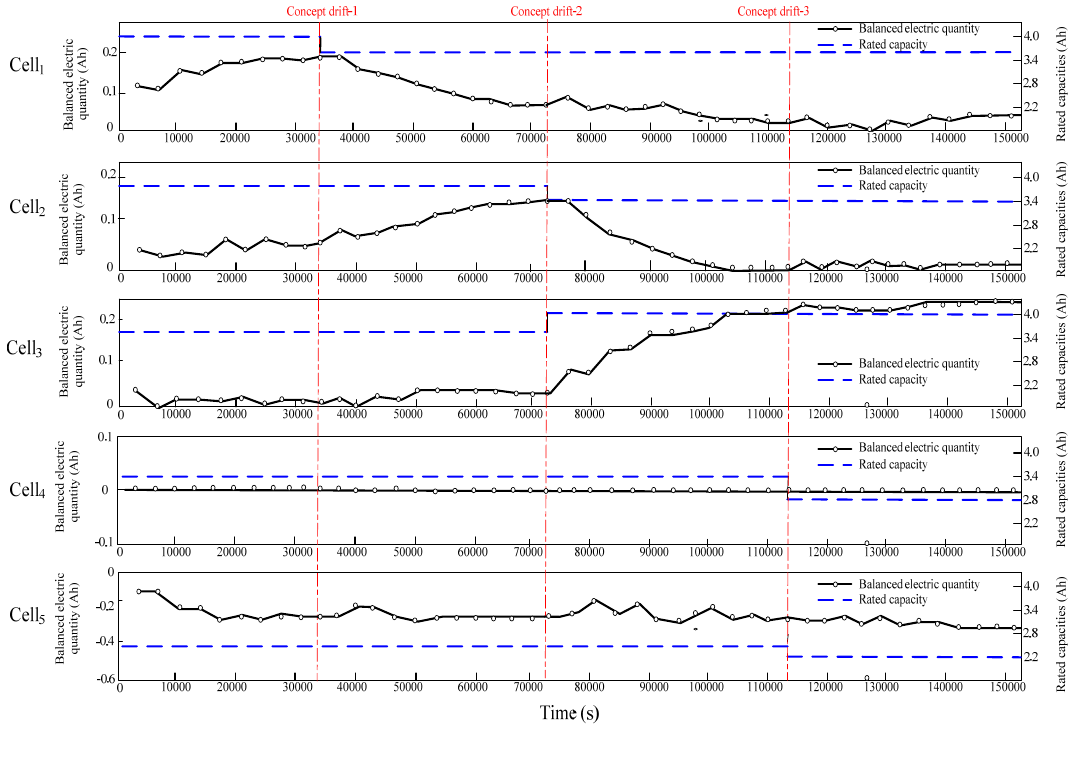
Figure 9. The balanced electric charge quantity and rated capacity of cells.